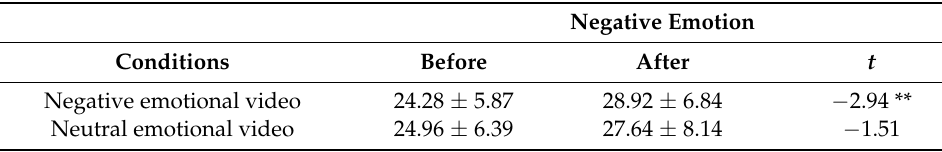
Table 5. The results of the pilot study for video